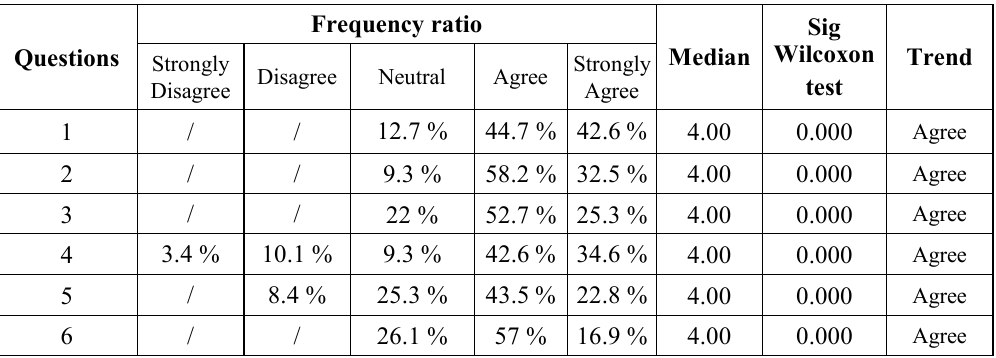
Table 7. Results of the Third